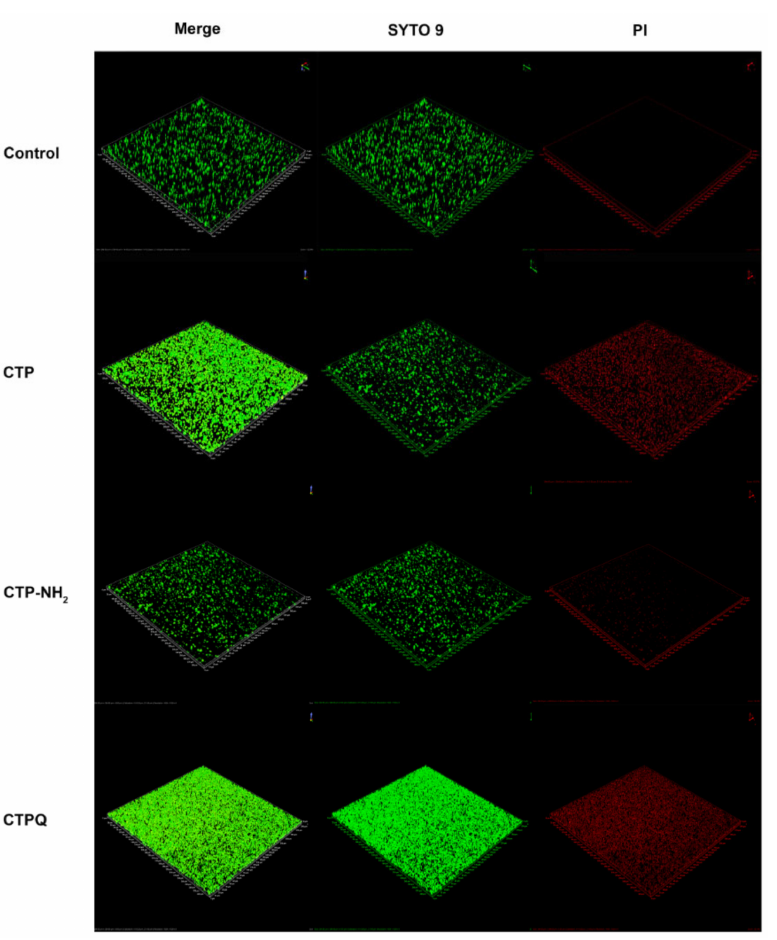
Figure 11. CLSM assay of S. aureus ATCC 43300 biofilm treated by CTPs (CTP, CTP-NH 2 , and CTPQ) at the MBC (64 µ g/mL) with 40 × oil lens.